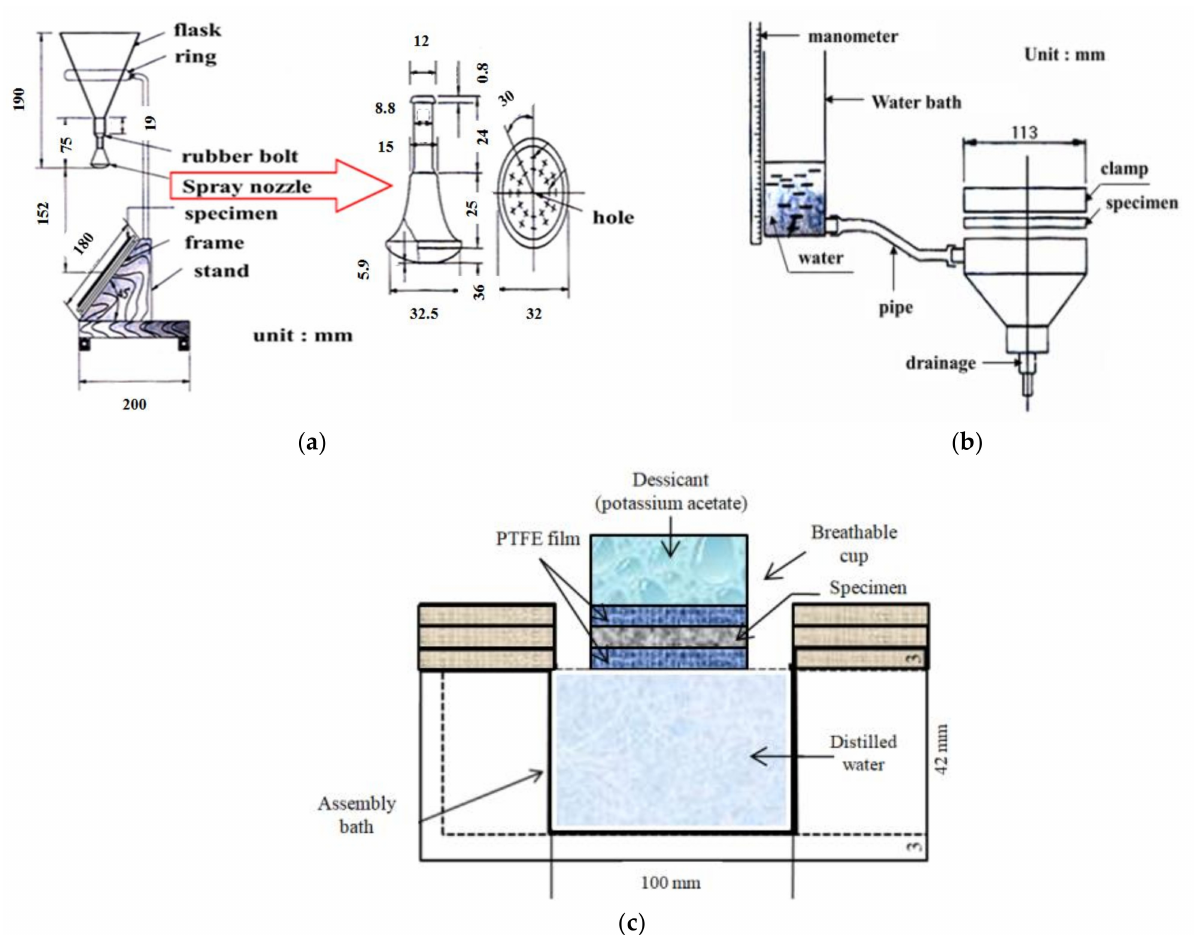
Figure 1. Schematic diagram of the water and vapor permeability measuring apparatus. ( a ) water repellency apparatus, Gelanots, Osaka, Japan (JIS L 1092), ( b ) hydrostatic apparatus, Textest AG, Schwerzenbach, Switzerland (JIS L 1092), and ( c ) WVP apparatus, Gelanots, Osaka, Japan (JIS L